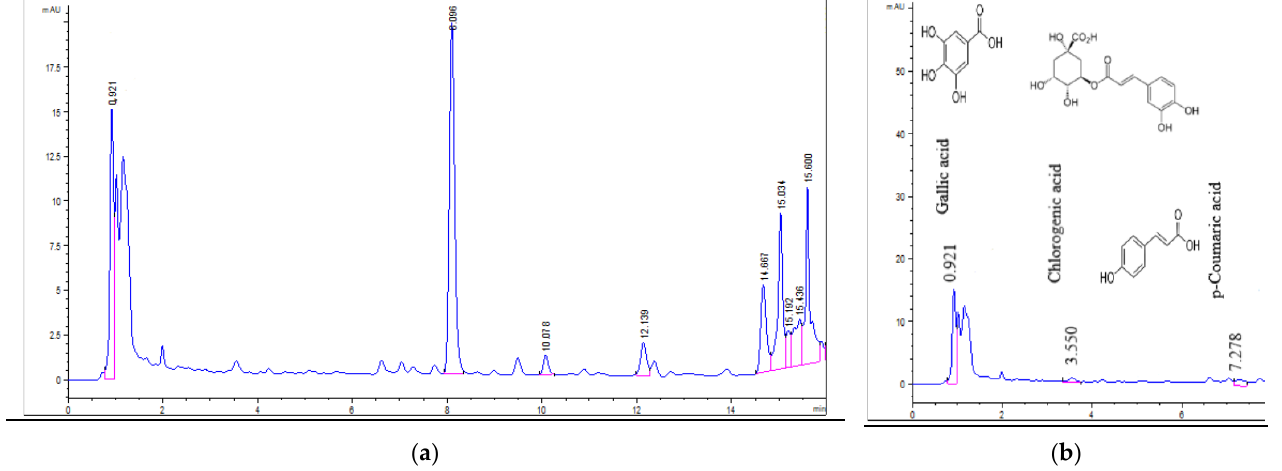
Figure 3. Chromatograms of m UBW ( a ); polyphenols in m UBW ( b ). The red lines mark the significant peak areas; UBW— U. barbata water extract, m —macerate.